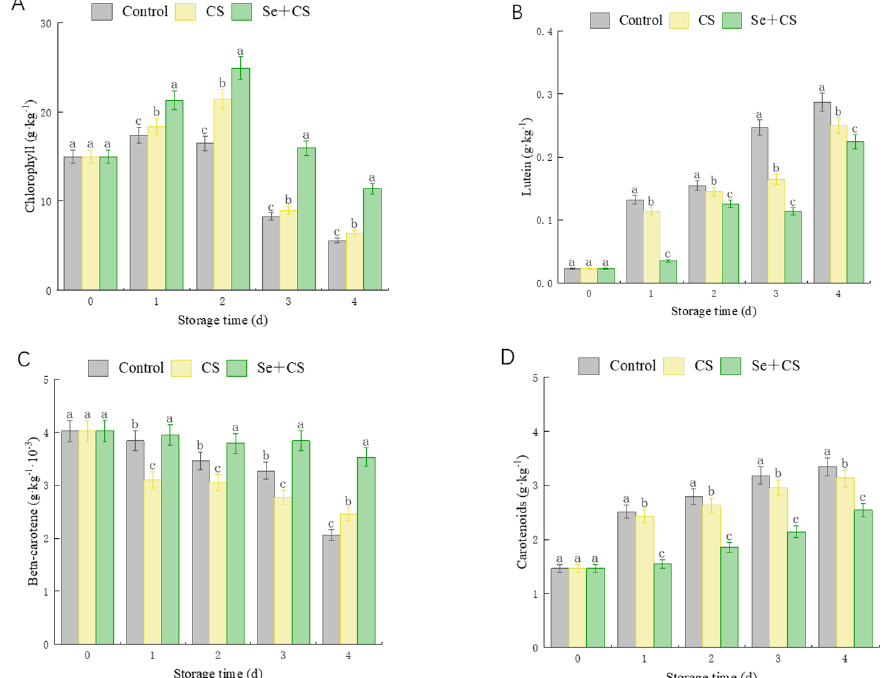
Figure 2. Pigment content for broccoli treated with Se+CS during storage ( A ). Chlorophyll content. ( B ). Lutein content. ( C ). β− -carotene content. ( D ). Carotenoid content. Different letters represent significant differences in the same group during storage ( p < 0.05) by Duncan’s multiple range test.